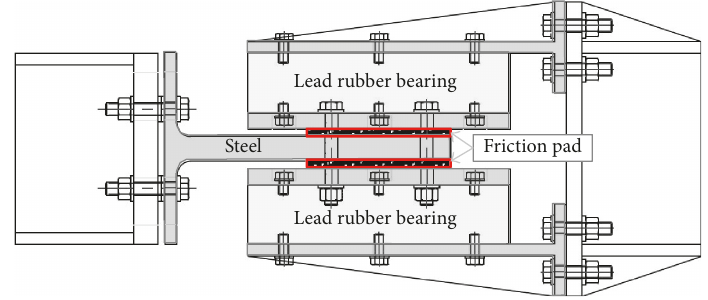
Figure 1: Section of the proposed